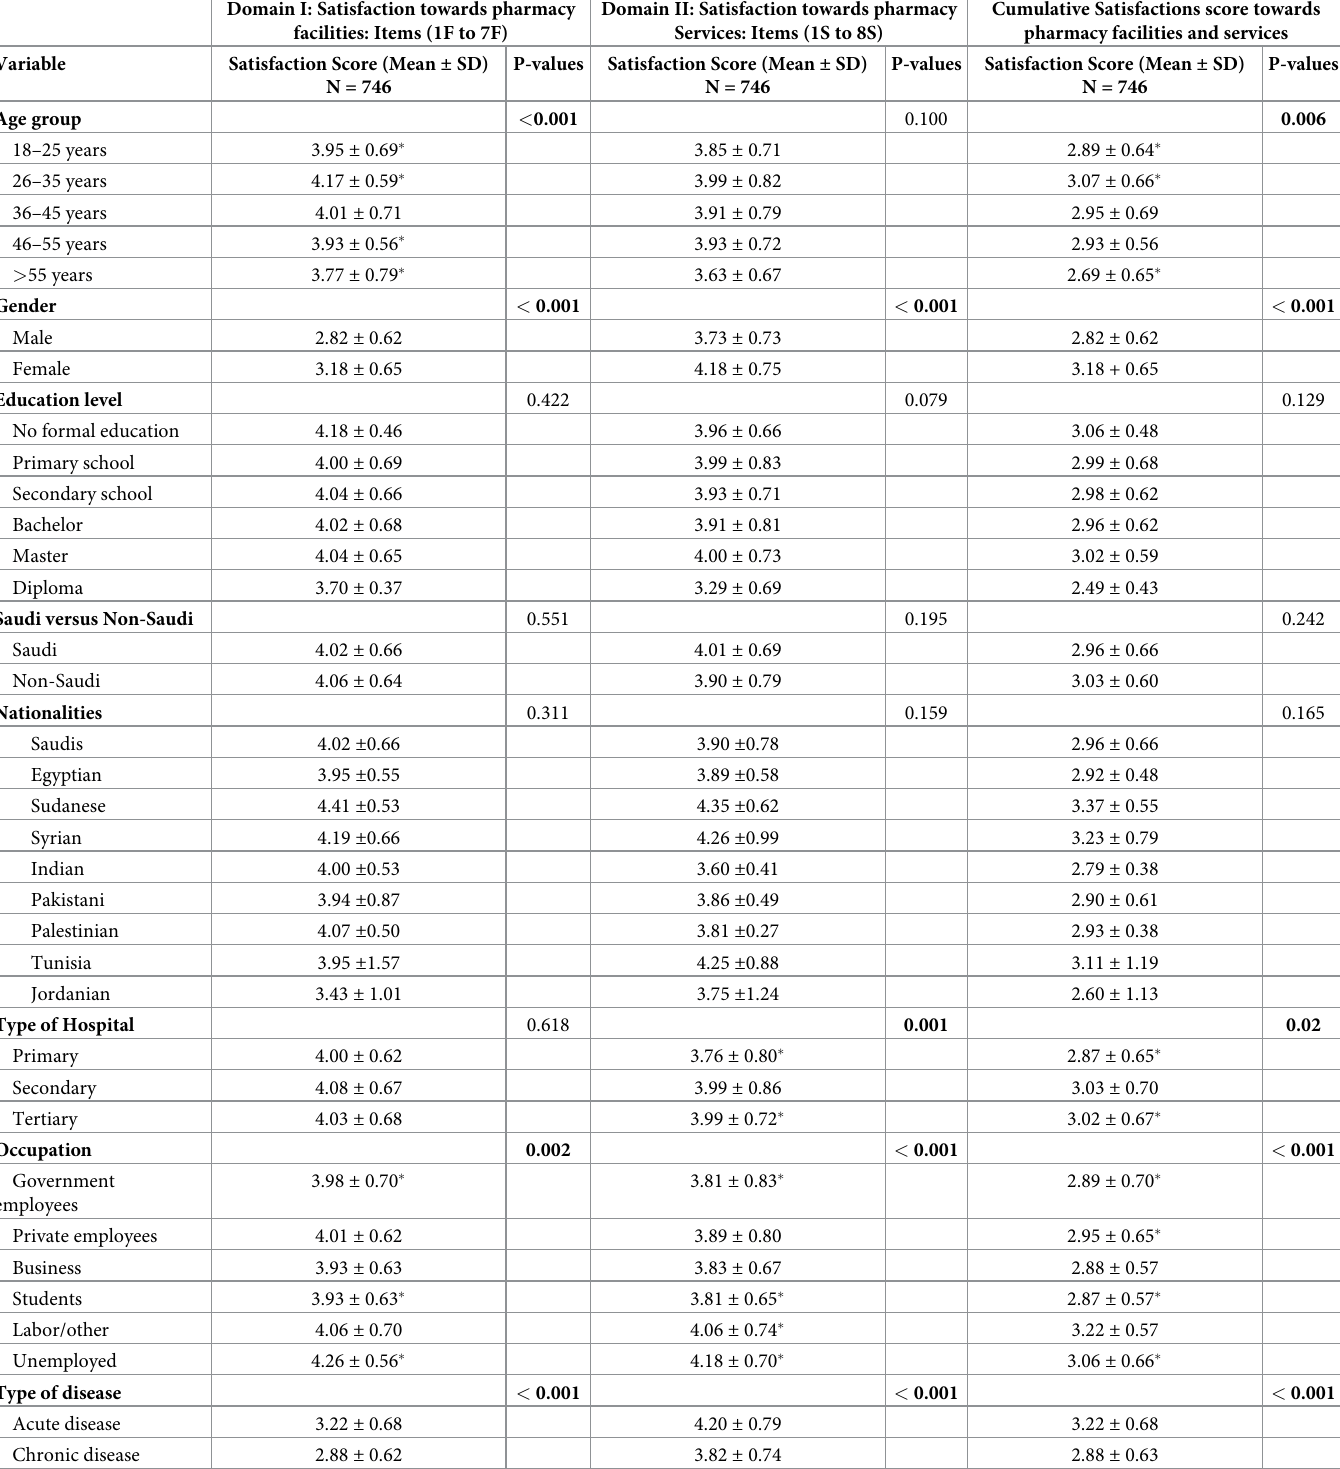
Table 3. Relationship between socio-demographics and satisfaction score among study participants. Domain I: Satisfaction towards pharmacy Domain II: Satisfaction towards pharmacy facilities: Items (1F to 7F) Services: Items (1S to